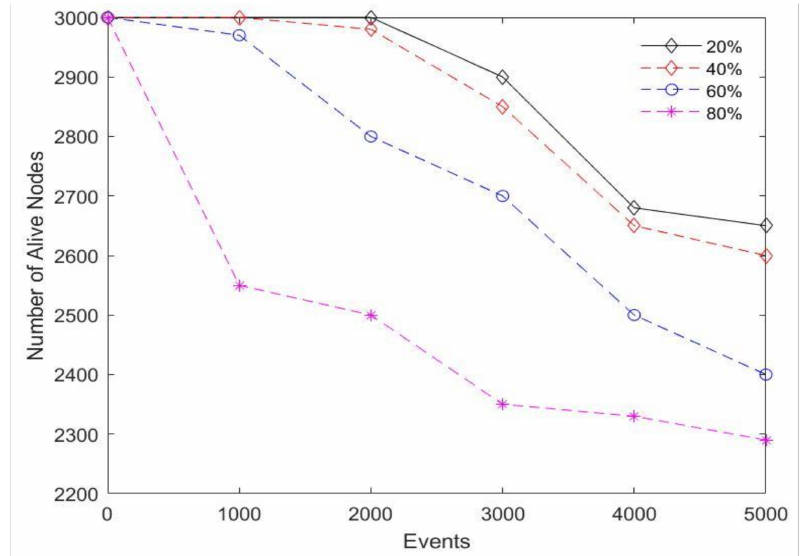
Figure 5. Number of alive nodes over time for different MC initial energy